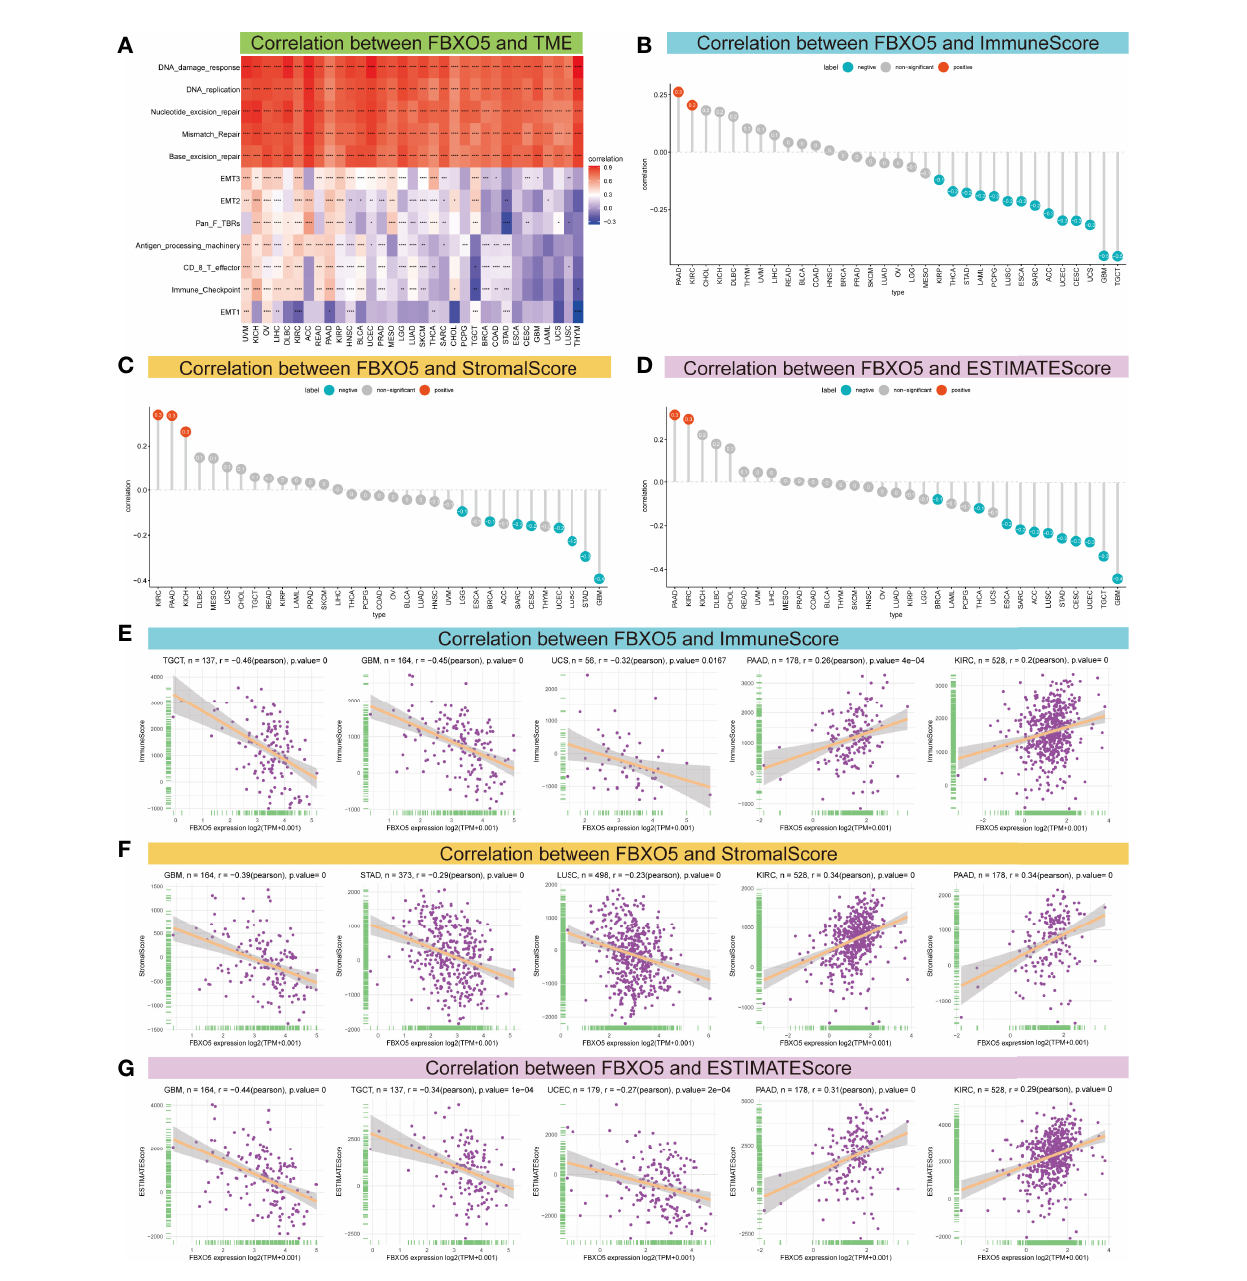
FIGURE 6 | Association between FBXO5 expression and TME. (A) Heatmap presenting the correlation strength between FBXO5 expression and TME-related terms in pan-cancer. * p -value < 0.05, ** p -value < 0.01, *** p -value < 0.001, and **** p -value < 0.0001. (B – D) Lollipop plots displaying the correlations of FBXO5 expression with ImmuneScore (B) , StromalScore (C) , and ESTIMATEScore (D) in pan-cancer, respectively. (E-G) Pearson ’ s analyses of the relationships between FBXO5 expression and ImmuneScore (E) , StromalScore (F) , and ESTIMATEScore (G) in the indicated tumor types,